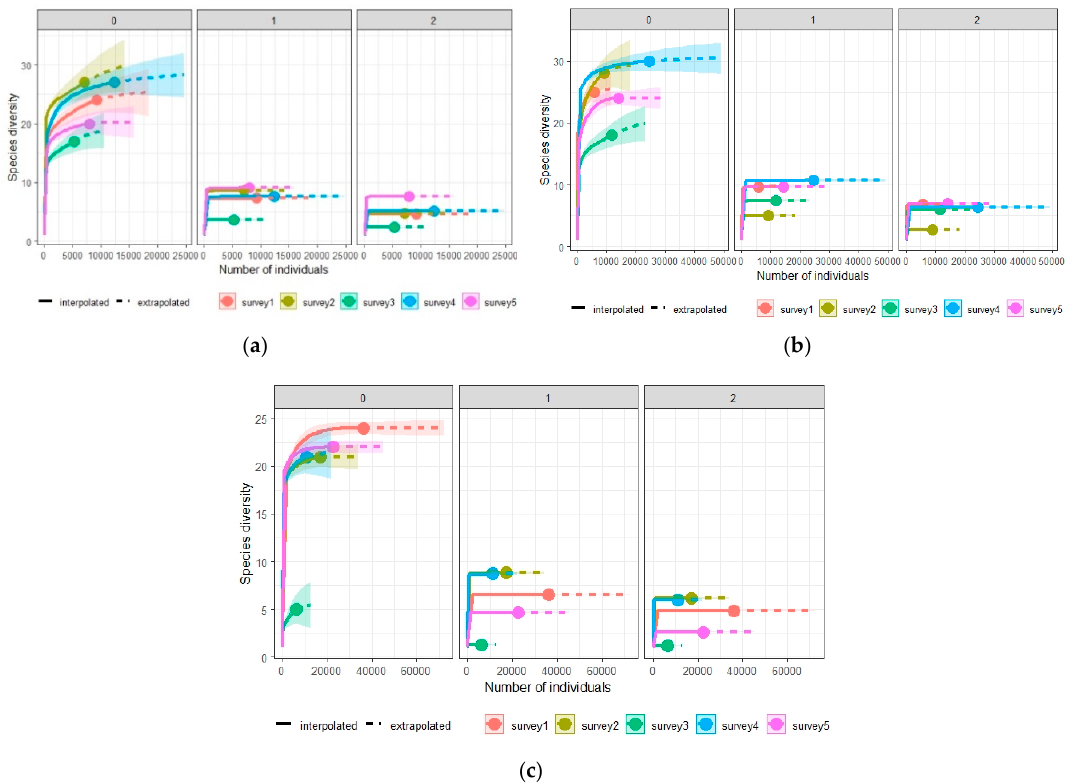
Figure 5. Abundance data-based rarefaction and extrapolation of Hill numbers for order q = 0–2 (species richness (q = 0), Shannon's diversity (q = 1) and inverse Simpson's diversity (q = 2)). For the five consecutive survey years (2016–2020) of PNNR ( a ), NNNR ( b ), and DNNR ( c ). The solid line is the rarefaction curve and the dotted line is the extrapolation curve, which goes up to double the size of the reference sample. The shaded area represents 95% confidence intervals obtained using the bootstrap method.